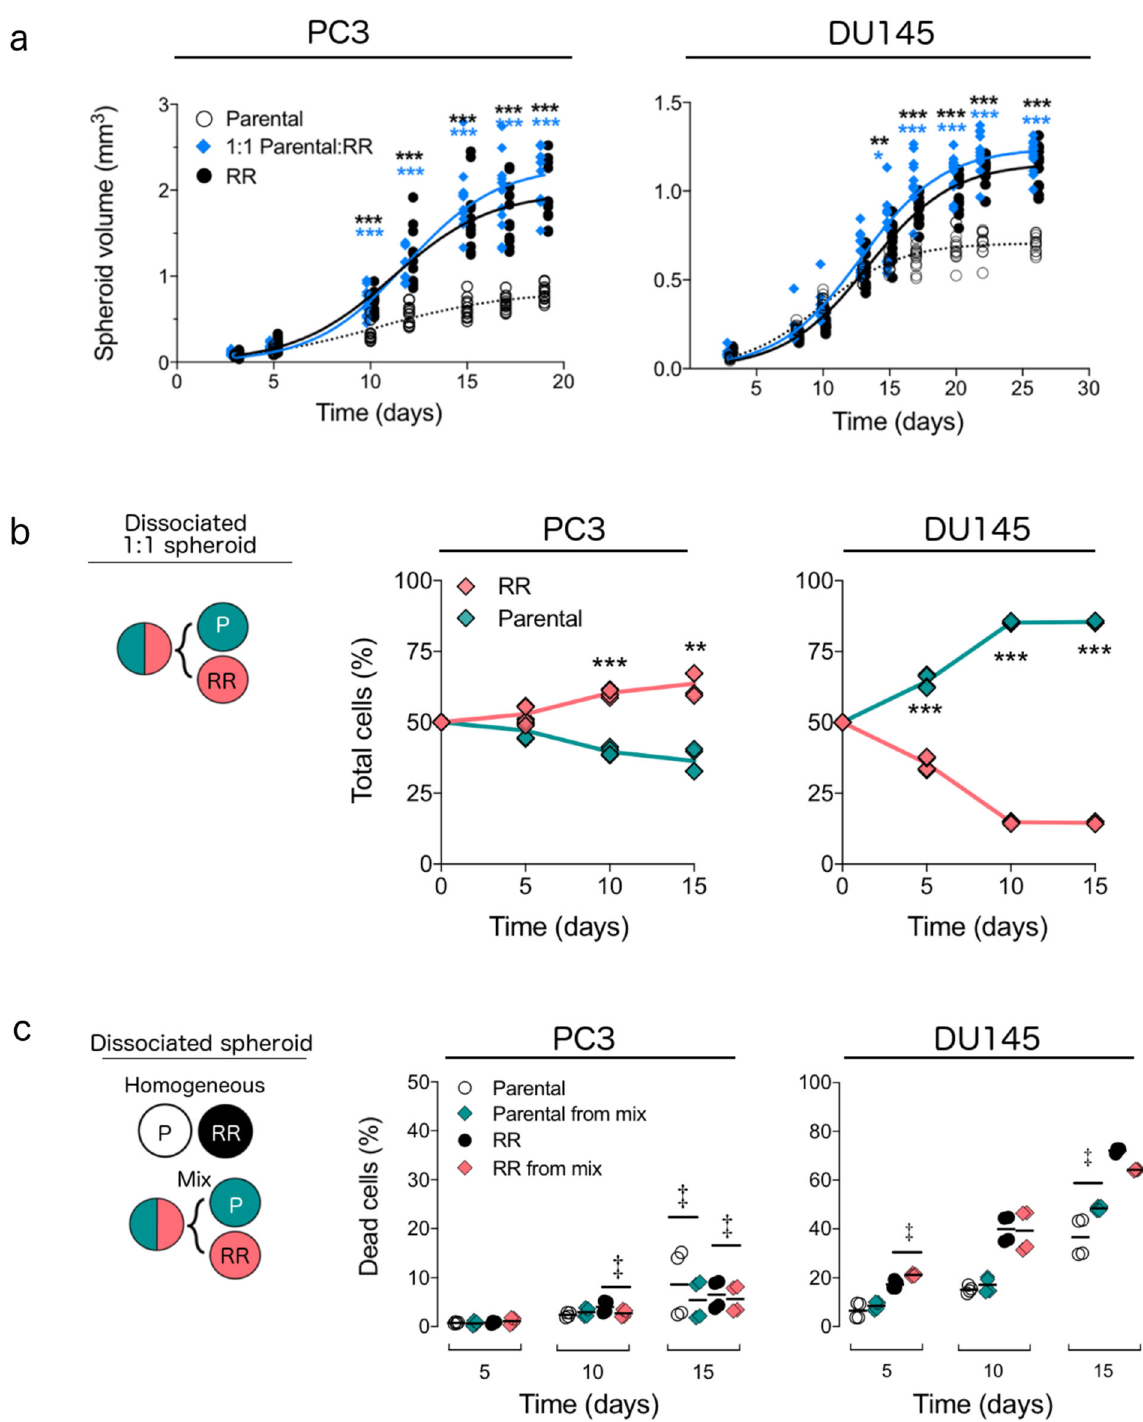
Fig. 2 Inclusion of radioresistant cell populations enhances the growth of unirradiated mixed 3D cultures and alters the survival of each population. a Growth curves of 3D spheroids comprising parental (white circles), radioresistant (RR, black circles), or 1:1 mix (blue diamonds) of parental:RR populations ( n = 12 spheroids for all except n = 11 for DU145 mix, pooled from 2 batches). Lines are the logistic growth model fi ts. * P adj < 0.05, ** P adj < 0.01, *** P adj < 0.001, 2-way ANOVA with post hoc Bonferroni correction comparing parental vs. mixed (blue asterisks) and parental vs. RR (black asterisks) spheroids. b Proportions of fl uorescent parental (GFP, green diamonds) and radioresistant (DsRed, pink diamonds) populations measured over time using fl ow cytometry from spheroids seeded as 1:1 mixture ( n = 4 experiments). Lines connecting symbols indicate the median value. *** P ANOVA with Sidak correction. c Percent of dead cells in each population isolated from homogeneous spheroids (parental, white circles; RR, black circles) or from mixed spheroids (parental, green diamonds; RR, pink diamonds) seeded as a 1:1 mixture of parental:RR ( n = 4 experiments). Bar indicates mean value. ‡ FDR < 0.05, overdispersed binomial regression with Benjamini – Hochberg correction. No P value was calculated for RR populations from DU145 spheroids on day 15 due to a poor statistical model fi